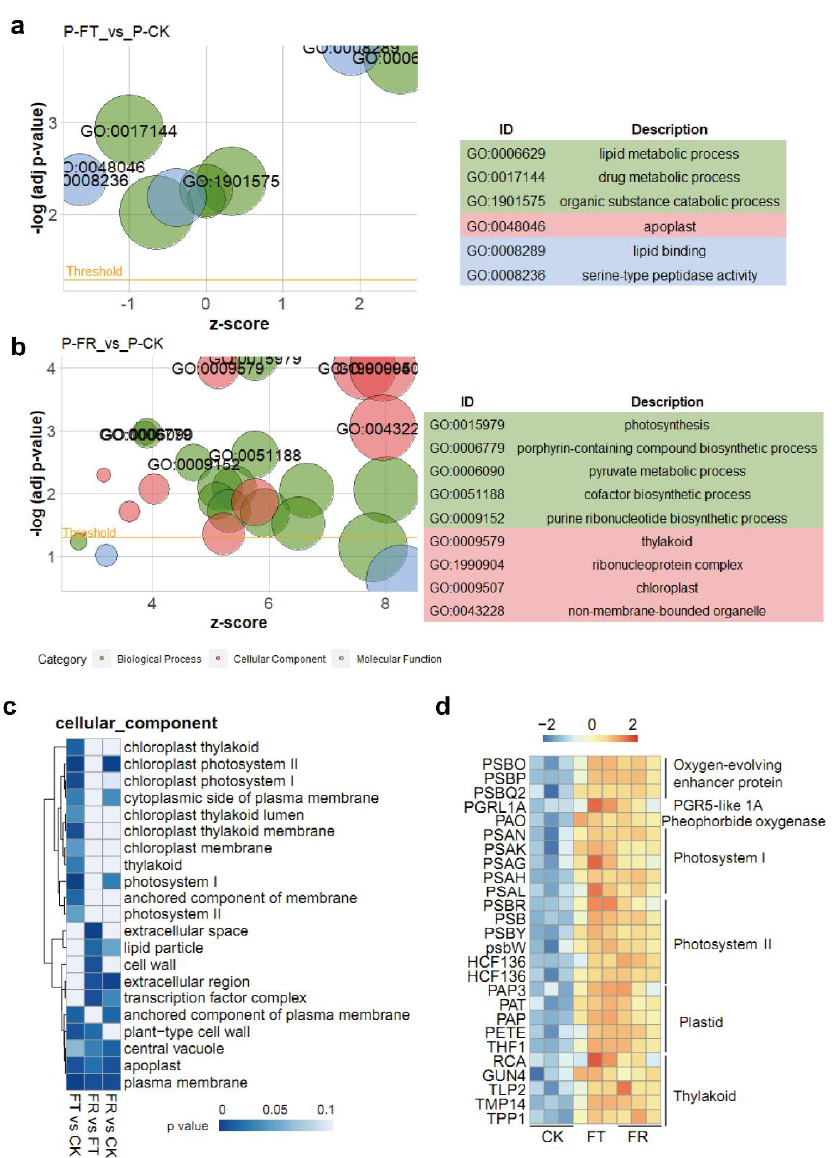
Figure 2. Gene ontology (GO) enrichment analysis of DAPs and DEGs in two comparisons. ( a ) The Go enrichment analysis of DAPs in FT vs. CK. ( b ) The Go enrichment analysis of DAPs in FR vs. CK. The x -axis represents the z-score of GO enrichment, while the y -axis represents − log 10 adjusted p -value. The dot sizes represent the number of DAPs. GO terms are labeled with a cut-off (adjusted p -value < 0.05). ( c ) The cellular component enrichment of DEGs from three comparisons. The bar indicates the p -value of KEGG enrichment. ( d ) Heat maps show the abundance of representative transcripts from cellular component enrichment. The enrichment pathway of DEGs is shown on the right. The bar indicates the significant values of gene expression levels. Gene abbreviations are listed in Table